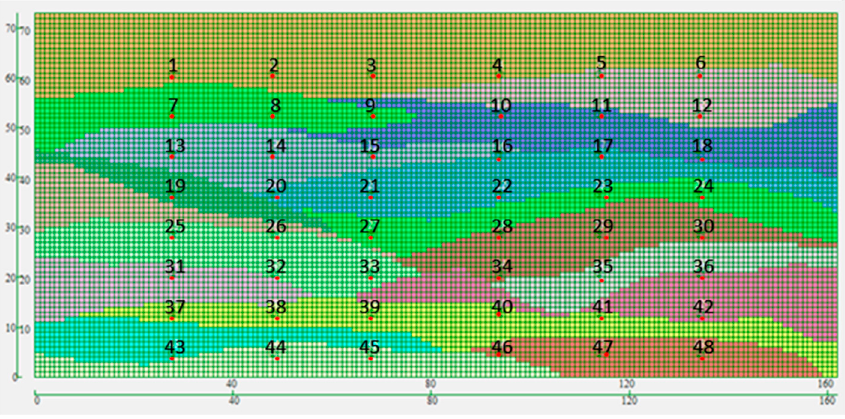
Figure 1. The finite element mesh of the working area of an 18-layered sandbox by VSAFT2 (Variably Saturated Flow and Transport utilizing the Modified Method of Characteristics, in 2D).